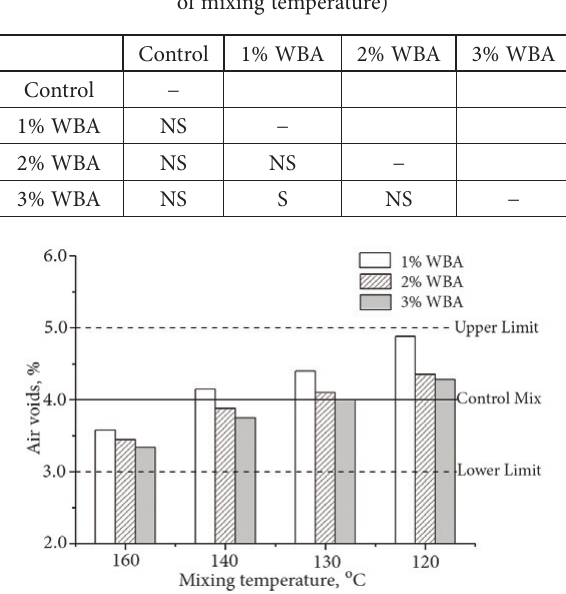
Table 6. Statistical analysis results on bulk density (irrespective